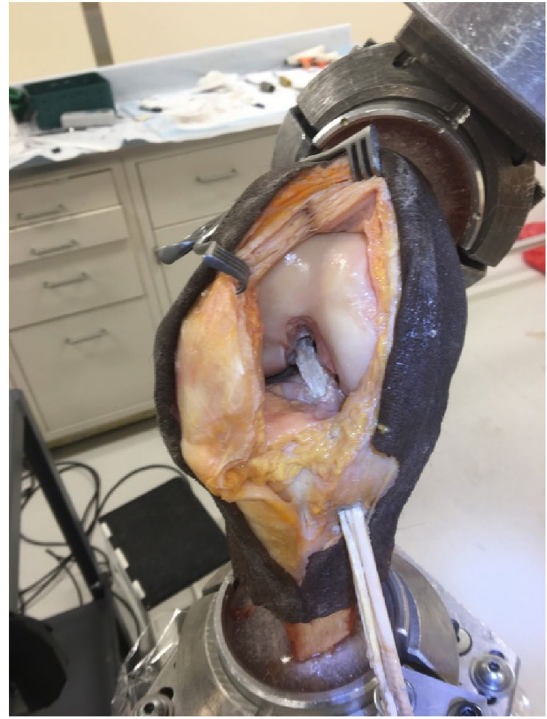
Fig. 1 Quadrupled hamstring graft after fixation with femoral cortical suspensory